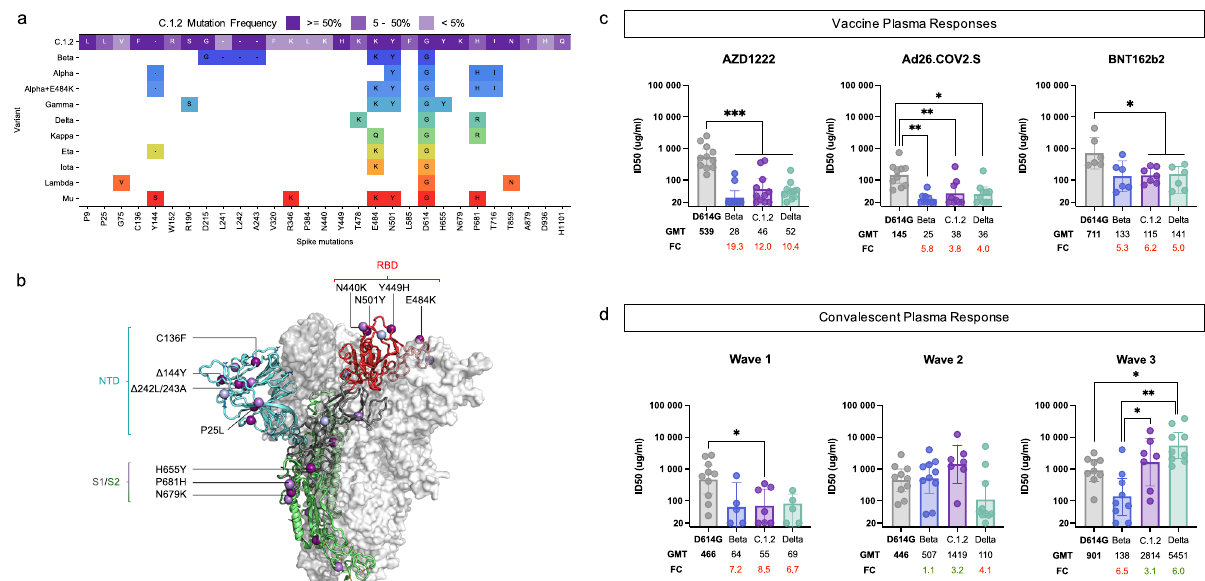
Fig. 2 Shared spike mutation results in similar immune responses. a Visualization of C.1.2 spike mutations, highlighting those shared with VOCs and VOIs (colored by the Nextstrain clade). All C.1.2 mutations are shown, and colored according to prevalence within the C.1.2 sequences (shown in key). For VOCs and VOIs only mutations present in at least 50% of sequences are shown (as determined by frequency information at outbreak.info, accessed September 13, 2021). b Schematic showing C.1.2 mutations on the RBD-down conformation of SARS-CoV-2 spike, with domains of a single protomer shown in cartoon view and colored cyan (N-terminal domain, NTD), red (C-terminal domain/receptor binding domain, CTD/RBD), gray (subdomain 1 and 2, SD1 and SD2), and green (S2). The adjacent protomers are shown in translucent surface view and colored shades of gray. Lineage-de fi ning mutations (found in >50% of sequences) are colored dark purple, with additional mutations (present in <50% of sequences) colored light purple. Key mutations known/predicted to in fl uence neutralization sensitivity (C136F and P25L, Δ 144Y, Δ 242L/243A, and E484K), or furin cleavage (H655Y and N679K) are indicated. Image was created using the PyMOL molecular graphics program. c , d Neutralization activity of biologically independent plasma samples taken from donors previously vaccinated with either AZD1222 ( N = 11), Ad26.COV.2.S ( N = 10 for D614G, Beta and Delta and N = 9 for C.1.2) or BNT162b2 ( N = 7 for C.1.2 and N = 6 for D614G, Beta, and Delta) ( c ) and patients previously infected during the fi rst ( N = 10 for D614G, N = 7 for C.1.2 and N = 5 for Beta and Delta), second ( N = 10 for D614G, Beta, and Delta and N = 7 for C.1.2) or third ( N = 9 for D614G, Beta, and Delta and N = 7 for C.1.2) waves in South Africa ( d ) against the wild-type (D614G), Beta, Delta, and C.1.2 variants. Bar graphs represent the geometric mean titer (GMT) for each group with the error bars representing the 95% con fi dence intervals, dots represent individual sample titers. Statistical signi fi cance based on the Wilcoxon two-tailed matched-pairs signed rank test are shown above graphs. p -values are denoted with “ * ” symbols: * p < 0.05, ** p < 0.01, and *** p < 0.001. GMT and fold- change (FC) differences relative to D614G are given below the graph, with red representing decreased titer and green representing increased titer. No adjustments for multiple testing were titer, GMT of 64), C.1.2 (GMT: 55) and Delta (GMT: 69) (Fig. 2d, left panel and Supplementary Fig. 3b). Convalescent plasma from